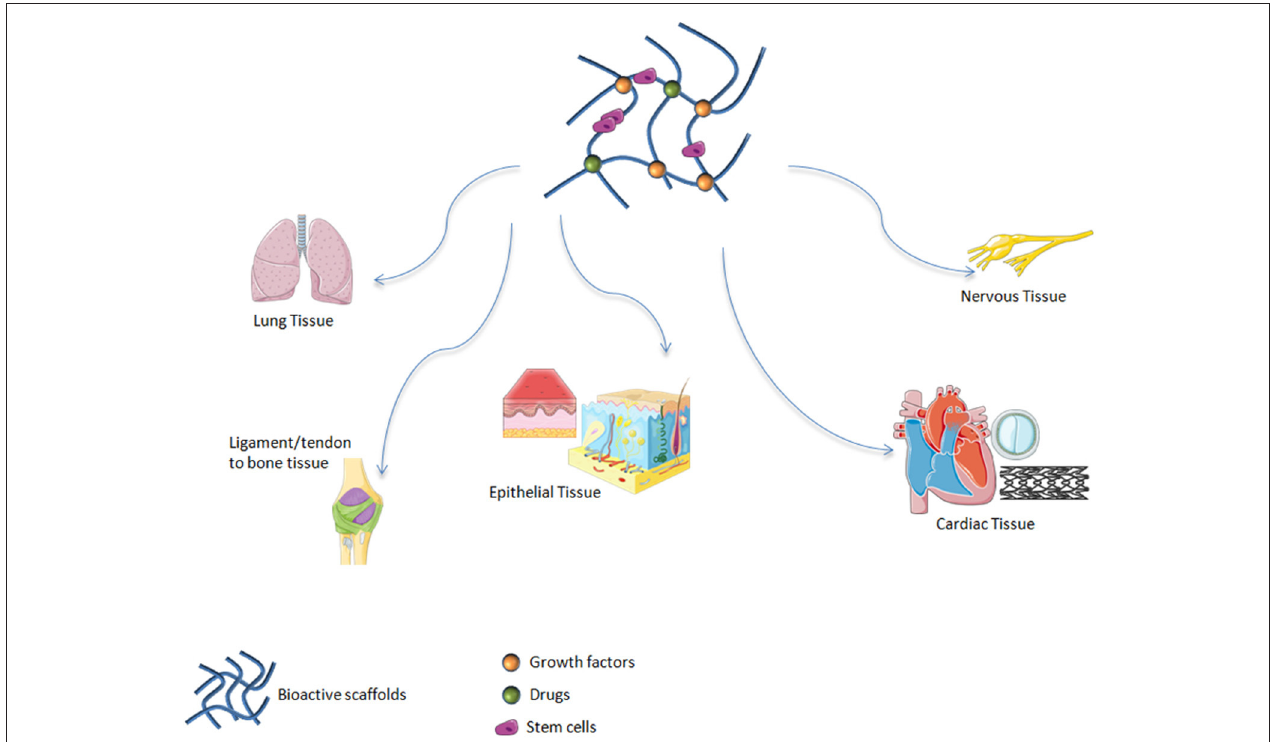
FIGURE 1 | Bioactive scaffolds applications in regenerative medicine. It has been demonstrated that these materials are suitable candidates for treating soft tissue damage including lung, ligament, tendon, epithelial, cardiac, and nervous